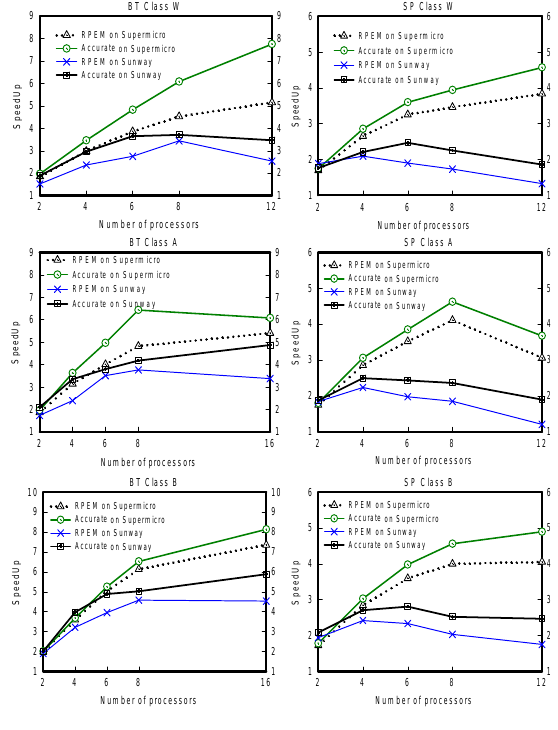
Figure 16. Expermental result of BT and SP For Supermicro server and Sunway cluster, there is a difference with respect to parallel performance. That is why the speedups of each application in two environments are not entirely consistent. But comparing two parallel programs for each application, programs generated by our algorithm always achieve better performance and faster upward trend in speedup. On the one hand, this shows that communication